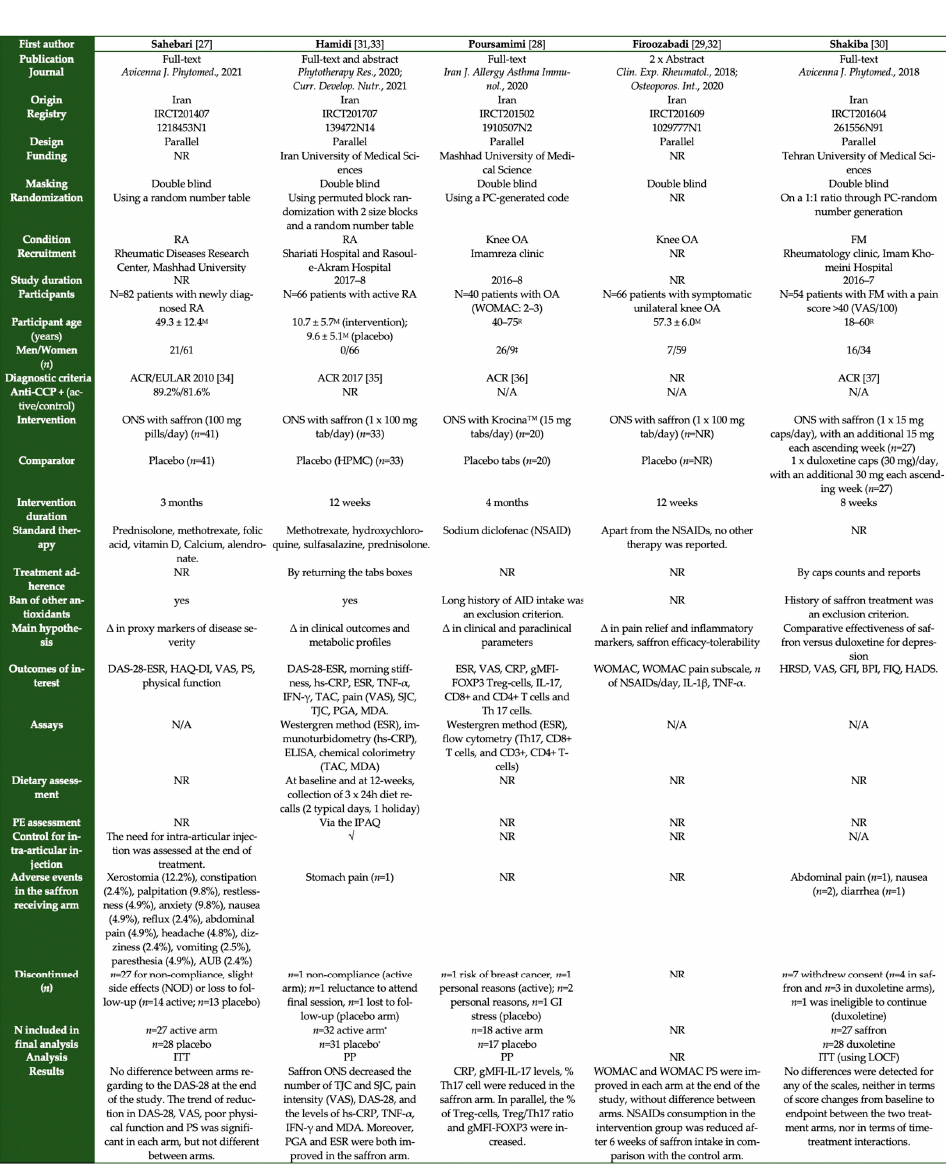
Figure 3. Characteristics of the parallel RCTs evaluating interventions with saffron in patients with RA, OA, or FM included in the qualitative synthesis. ACR, American College Of Rheumatology; AID, anti-inflammatory drug; anti-CCP, anti-cyclic citrullinated peptide; AUB, abnormal uterine bleeding; BPI, Brief Pain Inventory [40]; DAS-28, disease activity score -28 [47]; ELISA, enzyme-linked immunosorbent assay; ESR, erythrocyte sedimentation rate; EULAR, European League Against Rheumatism; FIQ, Fibromyalgia Impact Questionnaire [48,49]; FM, fibromyalgia; FOXP3, forkhead box protein P3; GFI, global fatigue index [44]; GI, gastrointestinal; gMFI, geometric mean fluorescence intensity; HADS, Hospital Anxiety and Depression Scale [46]; HAQ-DI, health assessment questionnaire-disability index [42]; HPMC, hydroxy-propyl methyl-cellulose; hs-CRP, high sensitivity C-reactive protein; HRSD, Hamilton Rating Scale for Depression [45]; IFN- γ , interferon- γ ; IPAQ, International Physical Activity Questionnaire [50]; LOCF, last-observation carry forward; MDA, malondialdehyde; N/A, not applicable; NR, not reported; NSAIDs, non-steroid anti-inflammatory drugs; ITT, intention-to- treat; OA, osteoarthritis; ONS, oral nutrient supplementation; PE, physical exercise; PGA, Physician Global Assessment [43]; PP, per protocol; PS, Pain score; RA, Rheumatoid arthritis; SJC, swollen joint count; Th, T helper; TJC, tender joint count; TNF-a, tumor necrosis factor α ; Treg-cells, regulatory T cells; VAS, visual analogue scale [39]; WOMAC, Western Ontario and McMaster Universities Osteoarthritis Index [41]. * Within the manuscript text, 31 participants were reported to have completed the active arm intervention and 30 controls, in the CONSORT flow chart it appears that 32 women from the intervention and 31 from the control arm were analyzed, but in the tables, the respective number of reported participants in active and comparator arms was 33 and 32. ‡ Reported data refer to the PP analysis; R range; M mean ± standard